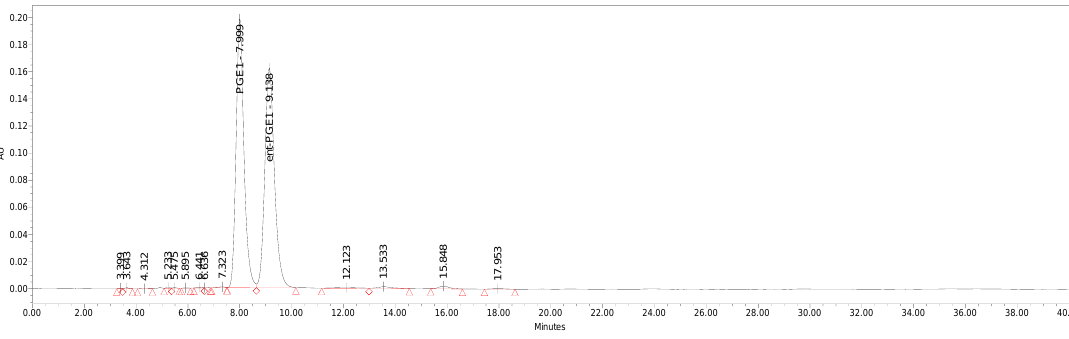
Figure 5. Chiral separation of the optical isomers of PGE 1 , R = 1.8. Optimized parameters: Eluent: MeCN:MeOH:water(pH = 4) = 30:10:60, column temperature 25 °C, wavelength 200 nm.